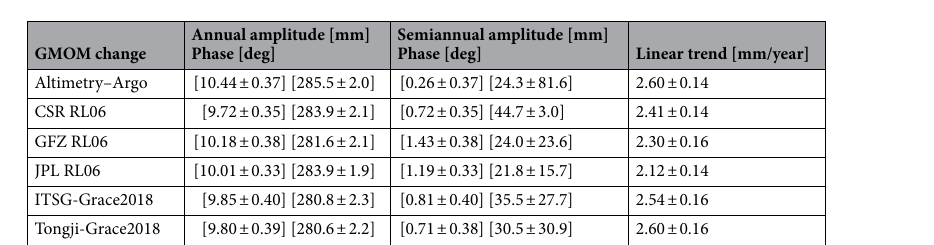
Figure 3. GMOM change estimation derived from altimetry minus Argo (Altimetry–Argo) and five GRACE solutions over the period from January 2005 to December 2016 without replacing the C 20 term.